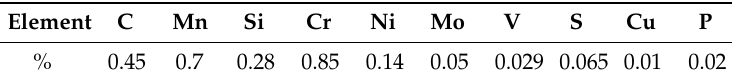
Table 2. The chemical composition of AISI 5140 carbon steel [12].